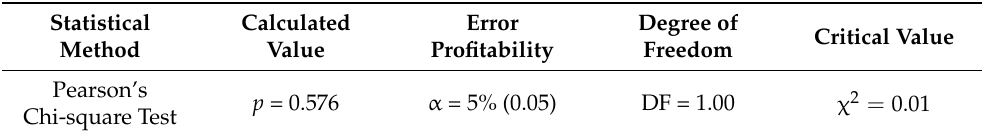
Table 2. The results of testing 1st hypothesis using the Pearson’s Chi-square test of independence. Source: Own